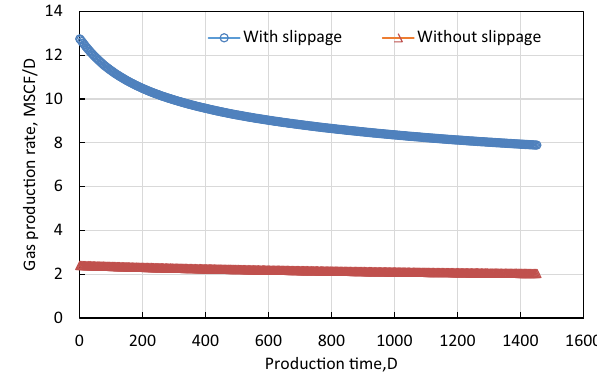
Fig. 4 Effects of gas slippage on the performance of shale gas simulation